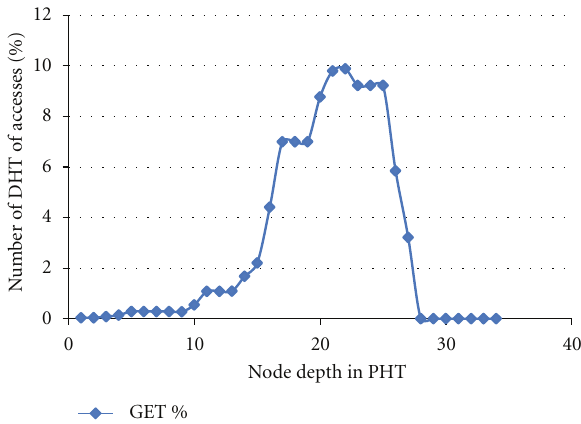
Figure 9: Number of accesses to the DHT against node depth in the PHT for the range query